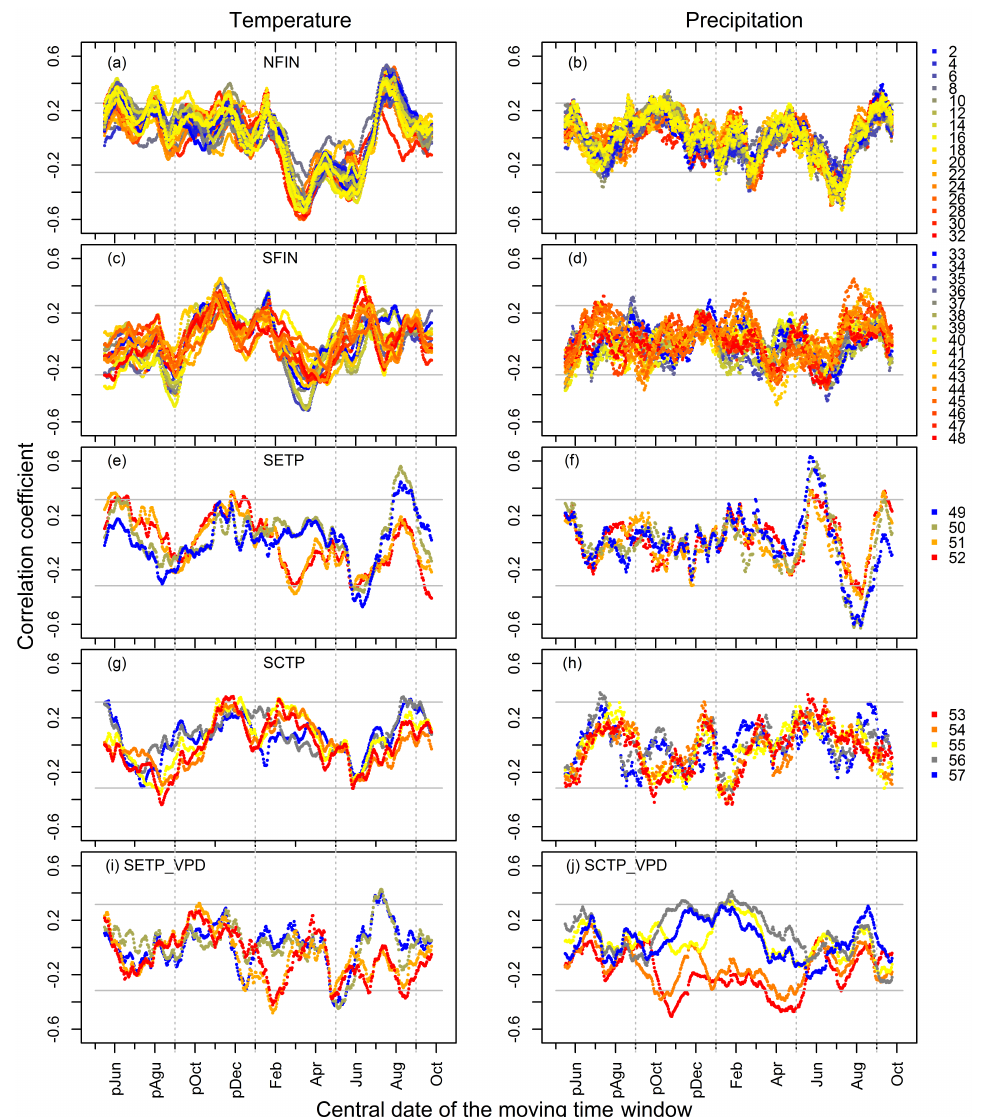
Figure 4. Correlation coefficients between the ring-width index chronologies (separate sub-figures for each region, and separate colours for each plot) and mean temperature (left column apart from the last row), precipitation sum (right column apart from the last row) and vapour pressure deficit (VPD) (the bottom row, for the SCTP and SETP) in moving time windows of 31 days. The x axis is the central day of the time window used in calculating the climate variables, with the first day of each month marked by ticks. The plot numbers are consistent with Table 1. Note that the colour gradient legend for sub-panels (a) – (b) is by two sites. The correlation periods for the Finnish and the Tibetan subsets are 1938–1997 and 1968–2006, respectively. The grey horizontal lines denote the 5% significance